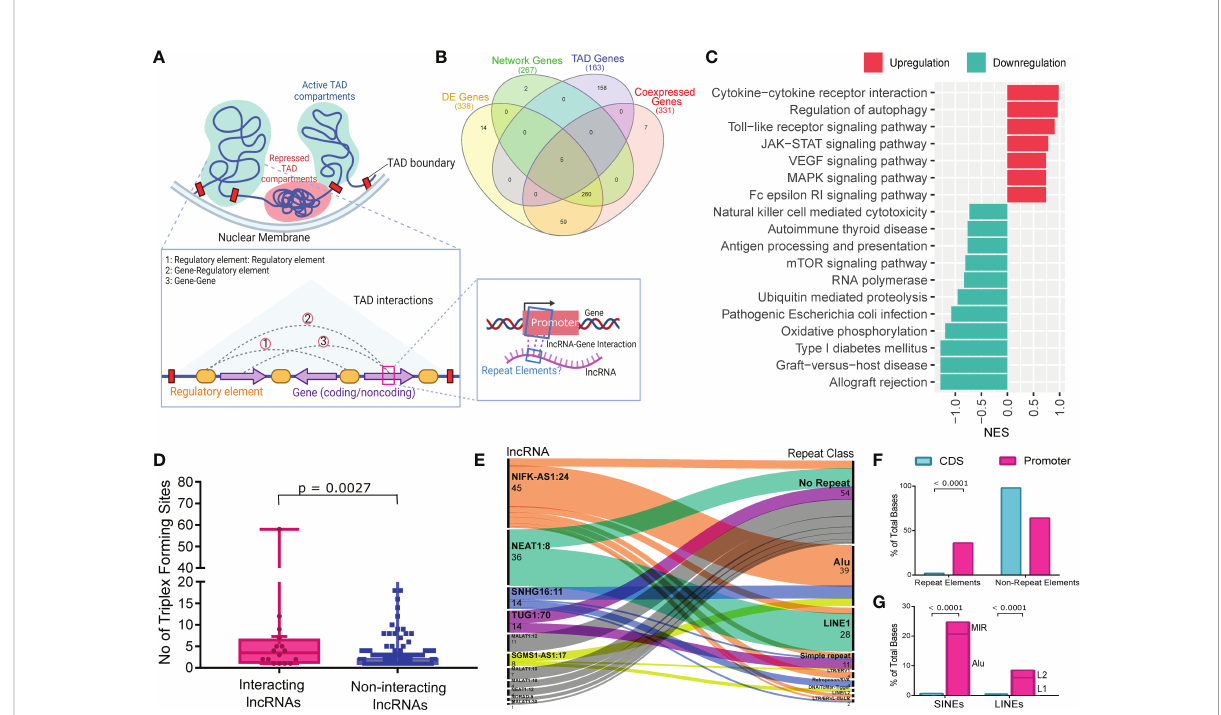
FIGURE 4 LncRNAs Interaction with the TAD genes and Repeat elements abundance at the Interaction sites. (A) Illustration of the TAD, type of interactions within the TAD and homology-based interaction between the lncRNA and promoter region of genes from the same TAD. (B) Venn diagram showing the number of protein coding genes from different steps of analysis and their overlap. (C) GSEA of the genes from the same TAD as of the interacting lncRNAs. The x-axis represents the Normalized Enrichment Score (NES), while the color represents the expression of the pathways. (D) Number of Triplex Forming Sites (TFS) between interacting lncRNAs and non-interacting lncRNAs. Upper bar shows statistical signi fi cance. (E) Repeat element abundance at the site of interaction within lncRNAs. The number of interacting sites within the lncRNAs and the corresponding repeat elements at these sites are represented in the alluvial plot on left and right sides, respectively. (F) Barplot showing the repeat element distribution between the promoter region and CDS region of the interacting TAD genes. Total bases covered by repeat elements were normalized against the total bases of the promoter and CDS. (G) Stacked bar plot showing the abundance of SINEs and LINEs; and Alu and LINE1 within SINEs and LINEs respectively, between the promoter and the CDS region. L1 and L2 represent LINE1 and LINE2 respectively. Upper bar shows statistical signi fi